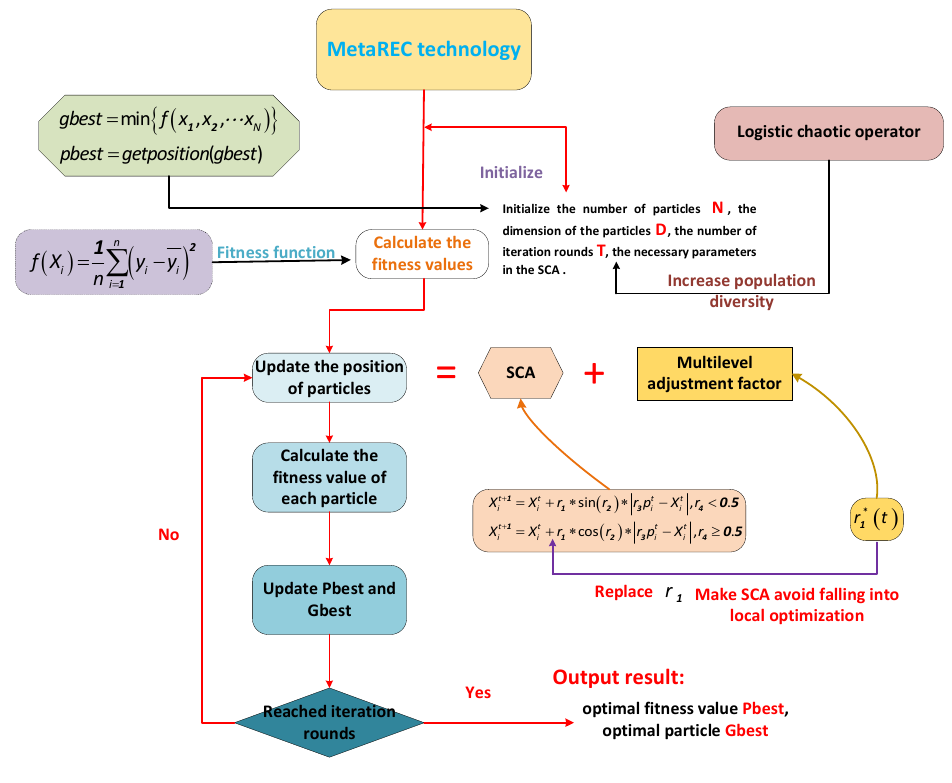
Figure 3. The MetaREC procedure.